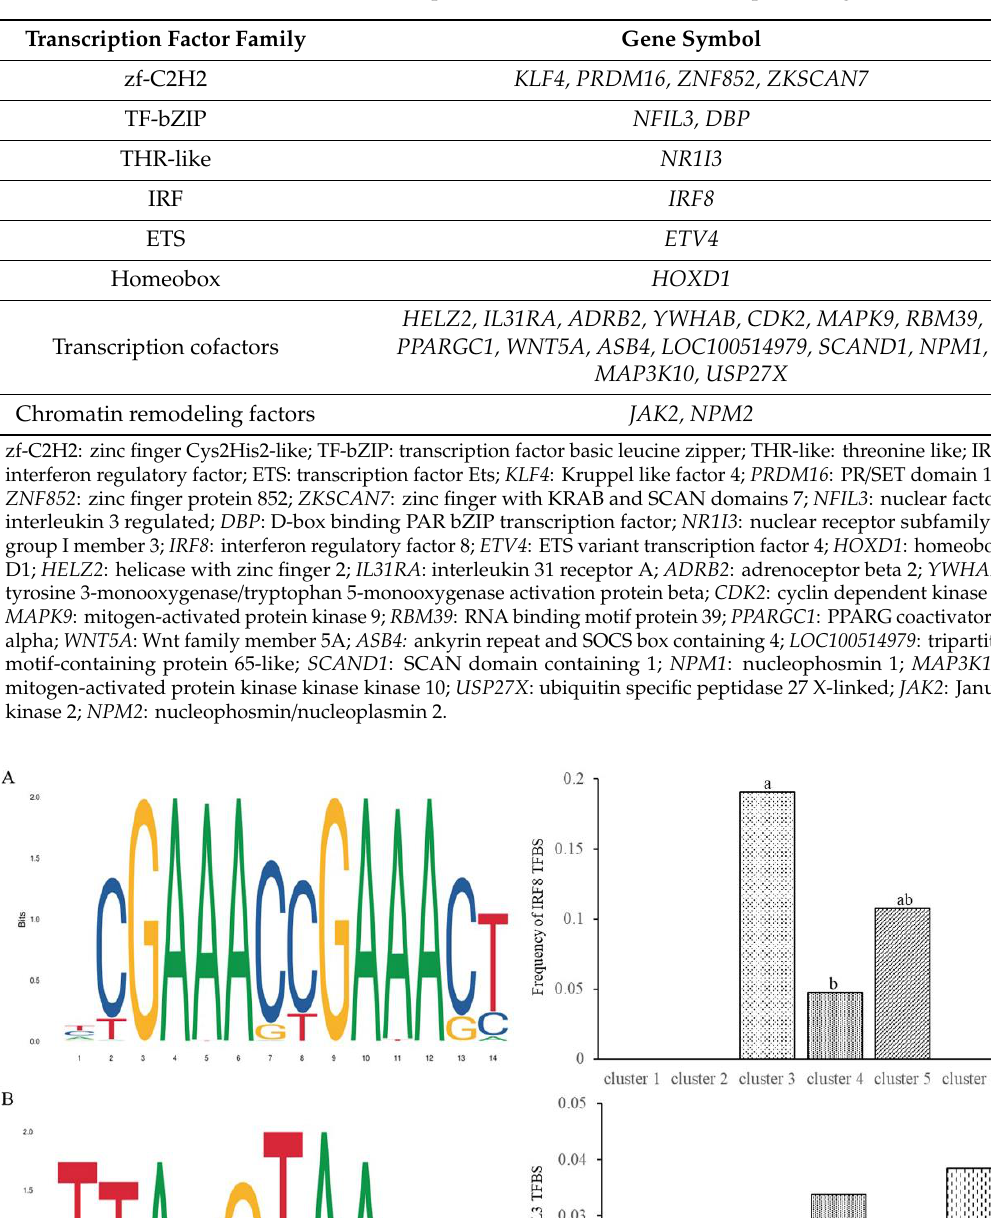
Table 2. Identification of transcription factors from di ff erential expression genes.